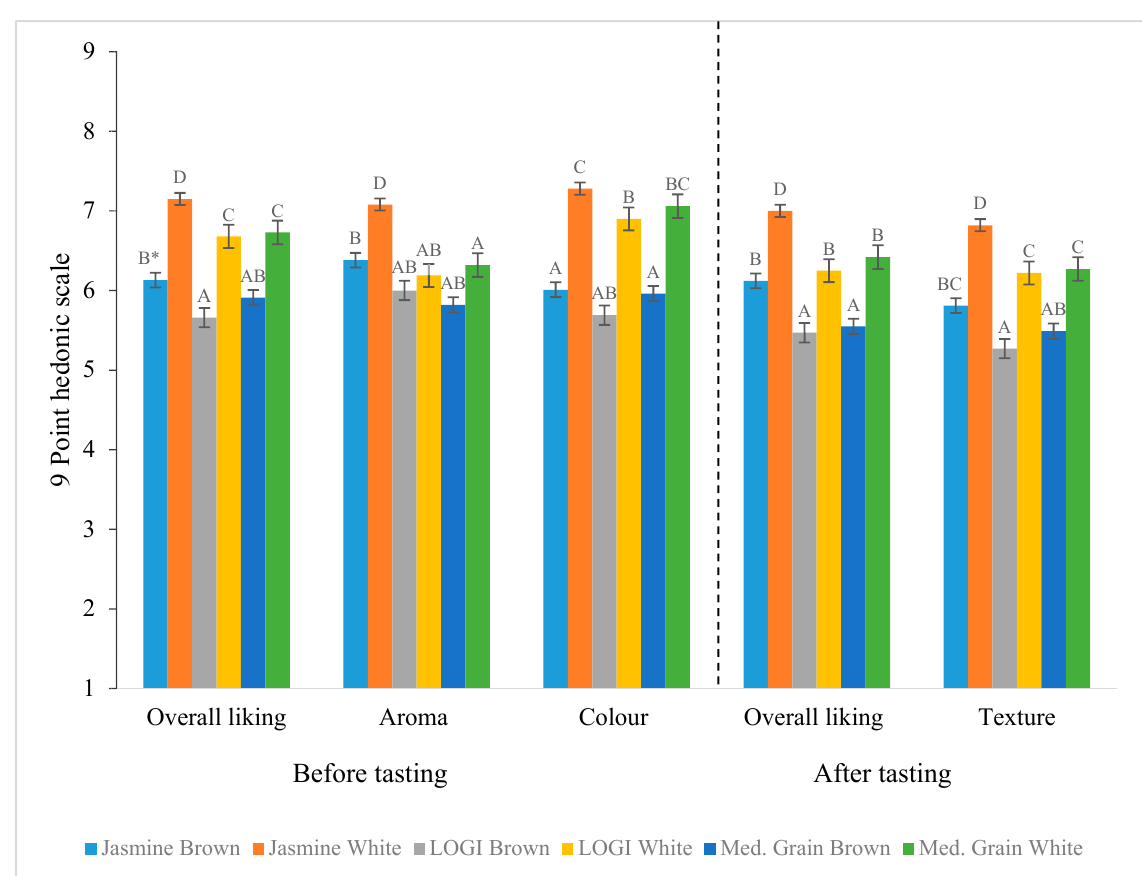
Figure 1. Mean liking (9-point hedonic scale, 1 = extremely disliked to 9 = extremely liked) of sensory attributes for rice varieties. * Different letters, shown as A–D, within attribute are statistically significantly different ( p < 0.05). Table 3. Linear mix model (repeated measures) ANOVA table for brown and white rice varieties before tasting.